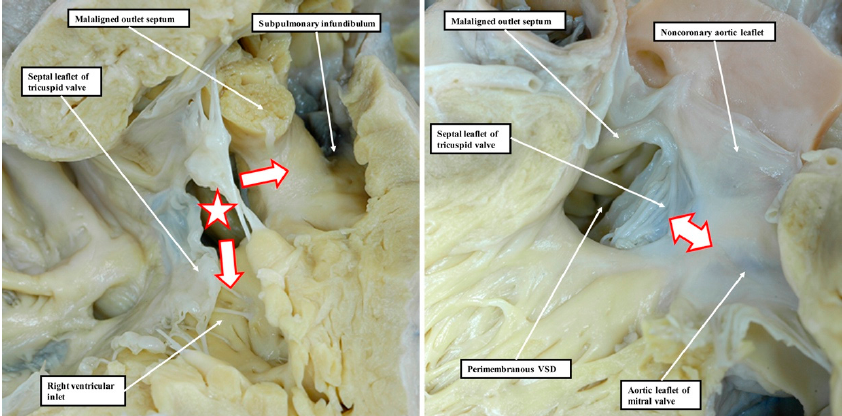
Figure 10. These images show a perimembranous defect that opens centrally at the base of the right ventricle but then, as is also the case for the defect shown in Figure 9, extends so as to open into both the inlet and outlet ventricular components. The left -hand panel shows the view from the right side. The defect is marked by the white star with red borders, with the white arrows with red borders showing the extension to the inlet and outlet components of the right ventricle. The right -hand panel shows the view from the left side. The defect is shielded by the septal leaflet of the tricuspid valve. An extensive area of fibrous continuity incorporating the atrioventricular component of the membranous septum forms the postero-inferior margin of the defect (double-headed white arrow with red borders). Note that, as in the defect shown in Figure 9, there is malalignment of the muscular outlet septum, which is recognisable as a discrete septal entity. It is deviated into the outlet of the right ventricle in an antero-cephalad